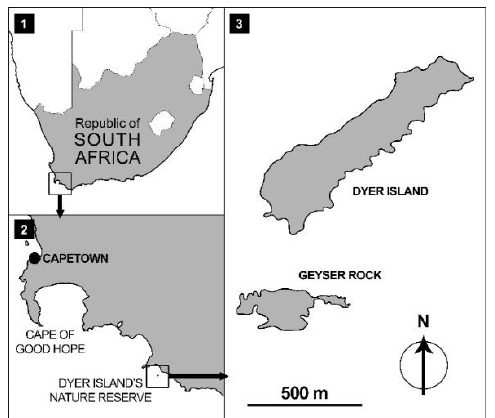
Figure 1. Map of Dyer Island’s Nature Reserve in Gansbaai, South Africa (34°41′ S; 19°2 4′